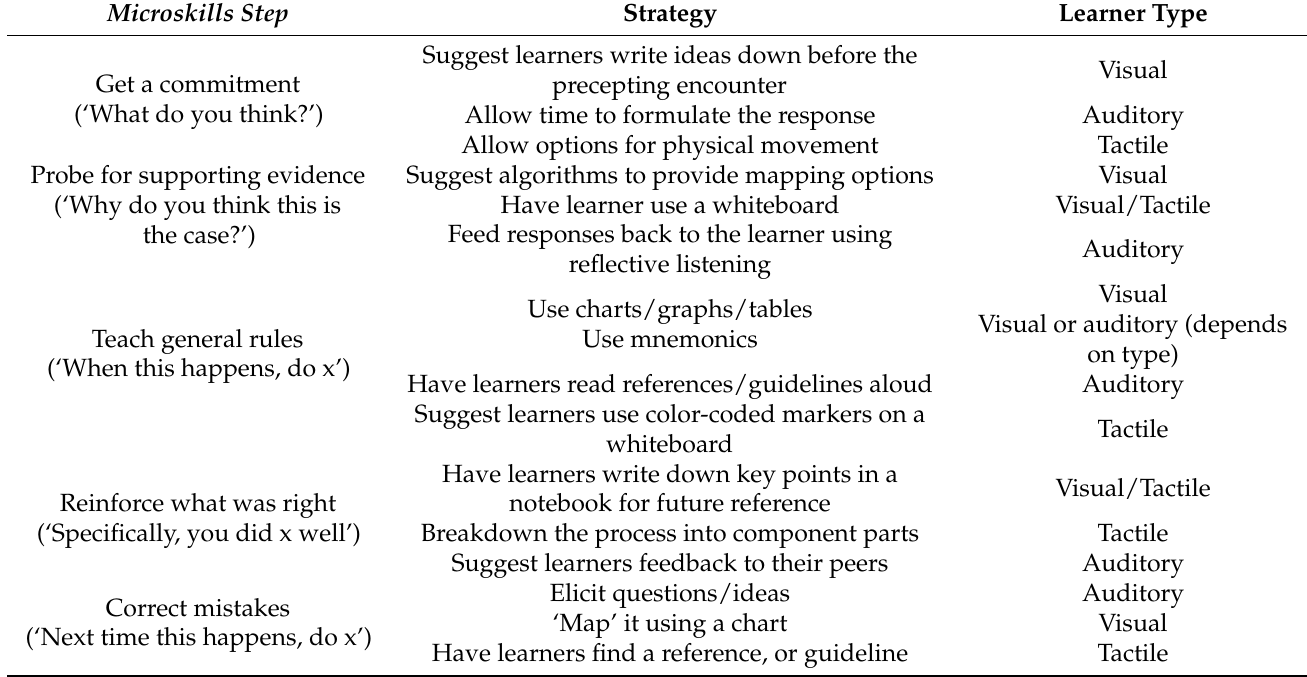
Table 1. Application of learning preferences to the five-microskills model (adapted from Delzell [14]). Microskills